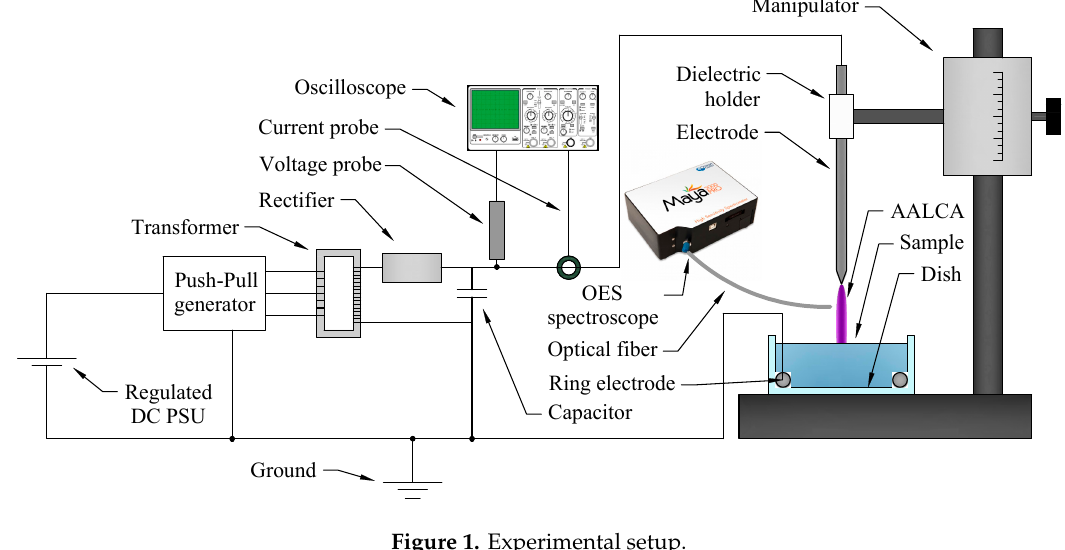
Figure 1. Experimental setup.